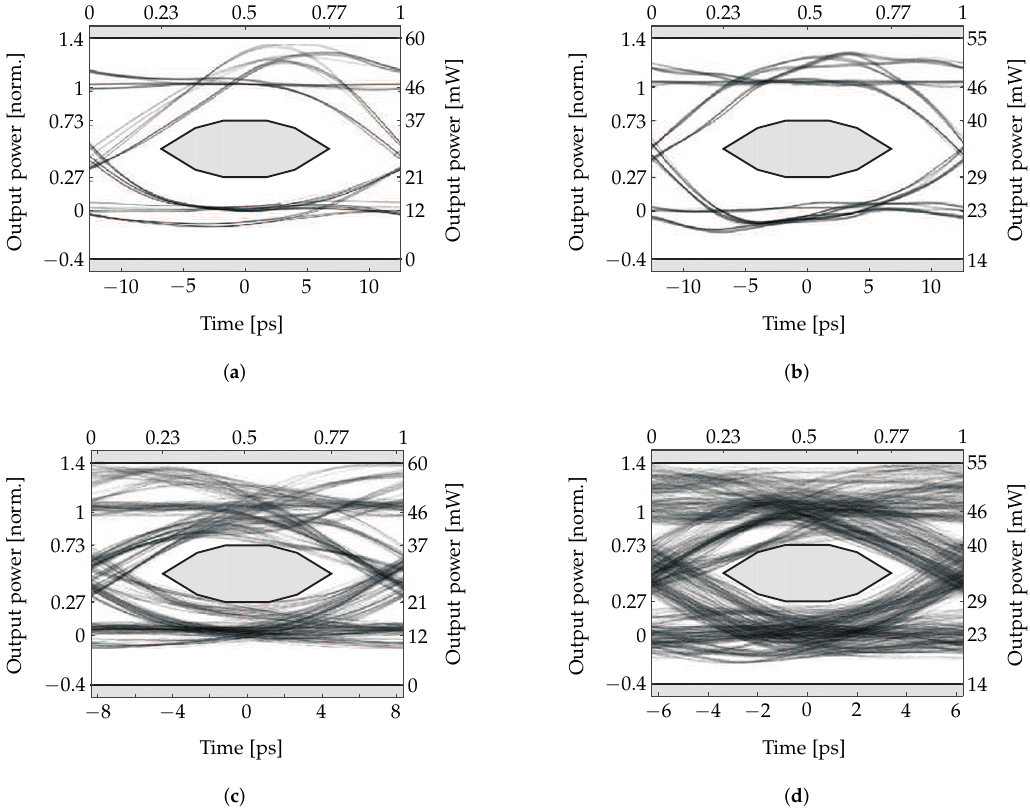
Figure 9. Eye diagrams for the operation condition considered in Figure8 using φ S = 240 ◦ , computed with a 2 15 1 bits-long non-return-to-zero (NRZ) pseudo-random bit sequence (PRBS) sequence. The − master section current is fixed ( I M = 8mA), while the slave section current is modulated from I S ,0 (corresponding to the logic “0” level) to I S ,1 (corresponding to the logic “1” level). ( a ) I S ,0 =